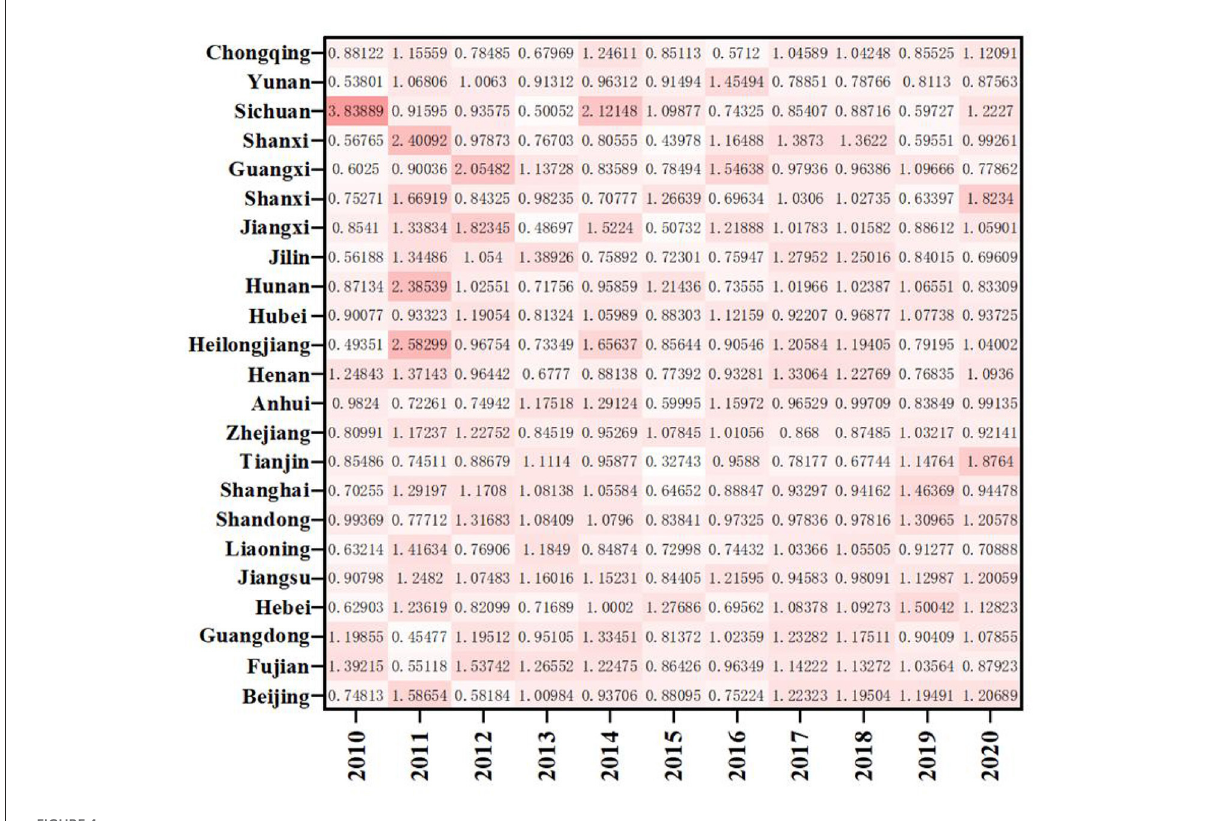
FIGURE4 The ERDS in different provinces from 2010 to